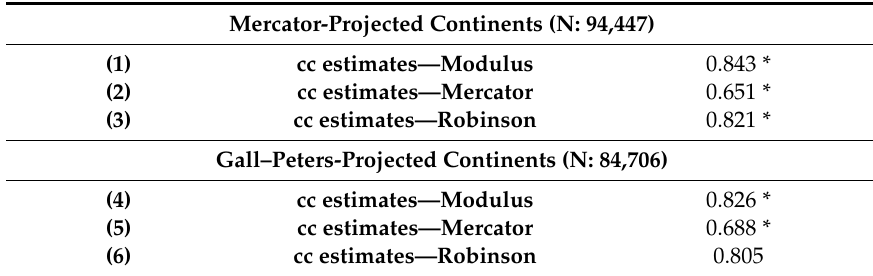
Table 5. Overview of the Pearson correlation coe ffi cients (cc) between the estimates and the ‘Modulus’, ‘Robinson’, and ‘Mercator areas’ (for the continents).